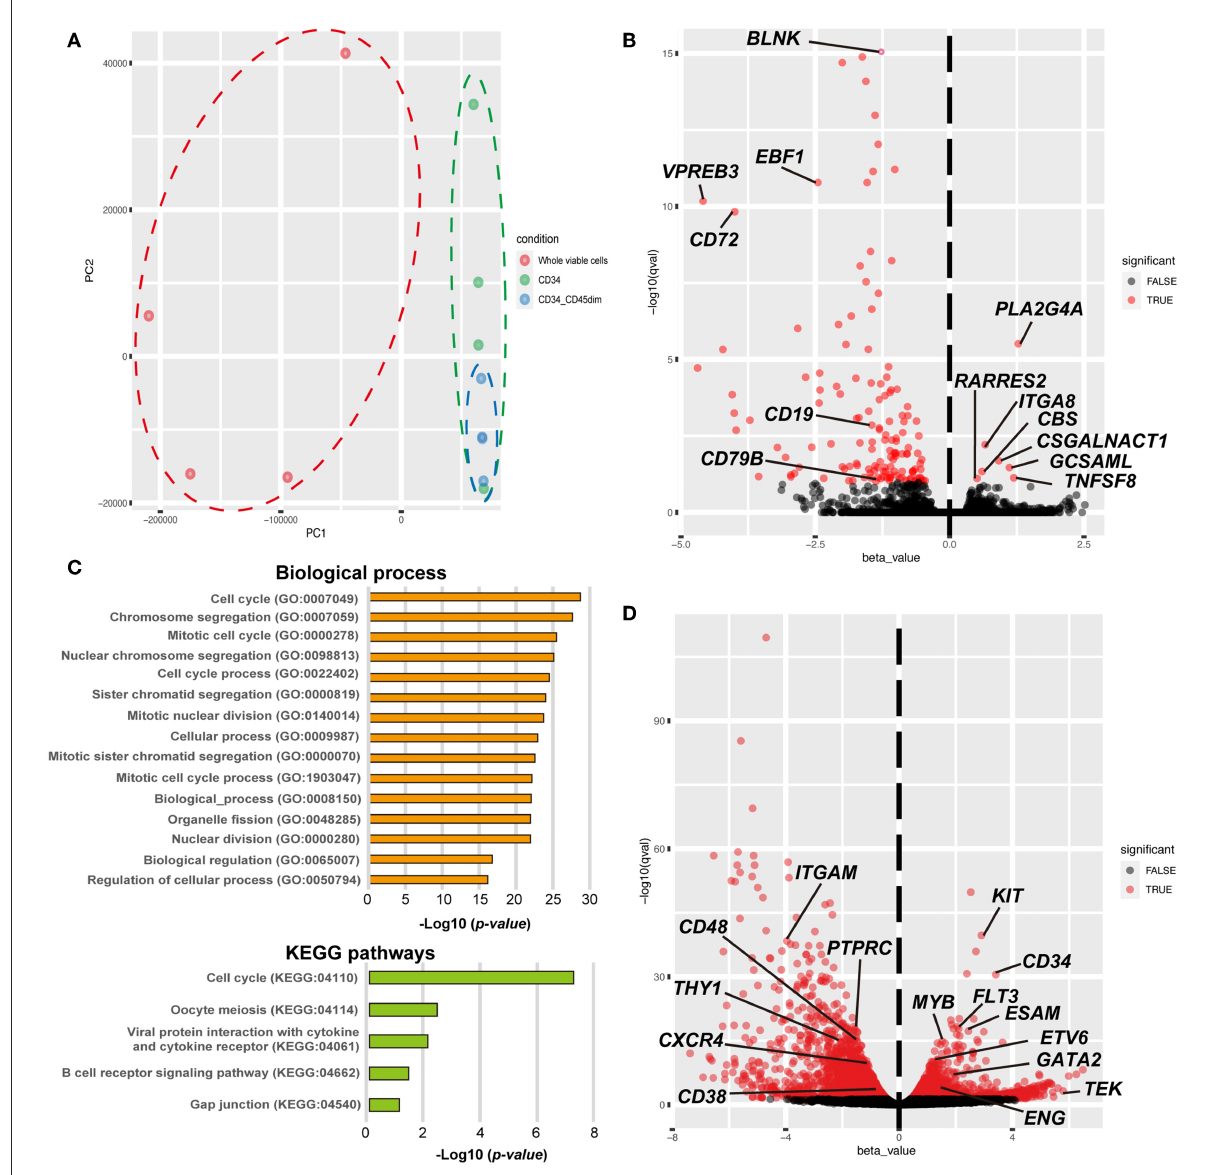
FIGURE3 Global gene expression profiling of canine haematopoietic stem and progenitor cells (HSPCs). (A) Principal component analysis of the global gene expression of canine HSPCs. Gene expression is demonstrated by dots and circles of red (whole viable cells), green (CD34 + cells), and blue [CD34 + /CD45 diminished (CD45dim) cells]. (B) The volcano plot shows the results of differentially expressed gene (DEG) analysis between CD34 + /CD45dim cells and CD34 + cells. Statistical significance was set as false discovery rate (FDR) < 0.1. (C) Gene ontology (GO) and Kyoto Encyclopaedia Gene and Genomes (KEGG)-based pathway enrichment analysis of the downregulated genes of CD34 + /CD45dim cells. The candidate terms of biological processes are illustrated with adjusted p -values < − Log10 16 (top). The candidate terms revealed by KEGG pathway analysis are demonstrated (bottom). (D) The volcano plot shows the results of DEG analysis between CD34 + /CD45dim cells and whole viable cells. Statistical significance was set as FDR <